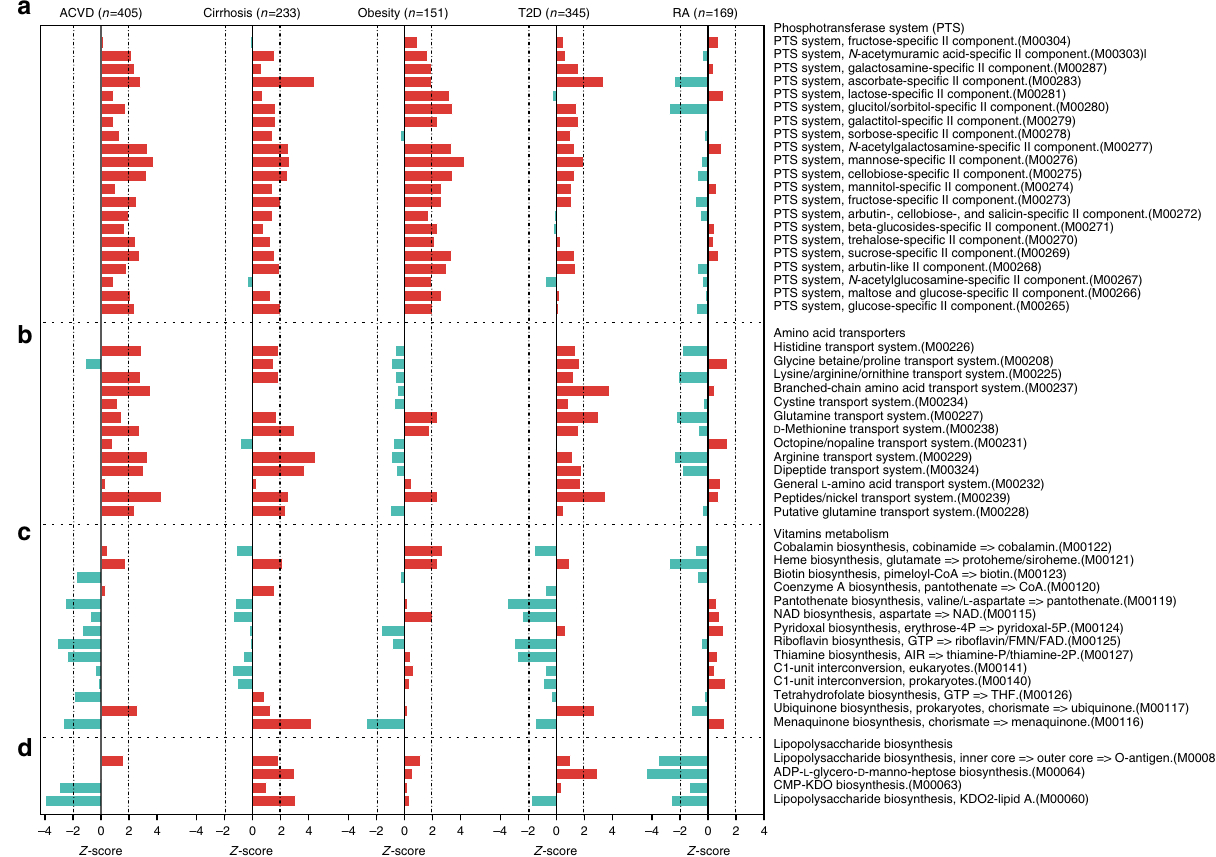
Fig. 6 Alterations in gut microbial functional modules in ACVD and other diseases. a PTS transport systems. b Amino acid transporters. c Vitamin metabolism. d LPS biosynthesis. Red , case-enriched; cyan , control-enriched, compared within each disease cohort (ACVD, total n = 405 including 218 cases; cirrhosis, total n = 231 including 120 cases; obesity, total n = 151 including 72 cases; T2D, total n = 345 including 171 cases; RA, total n = 169 including 95 cases). Dashed lines indicate a reporter score of 1.96, corresponding to 95% con fi dence in a normal